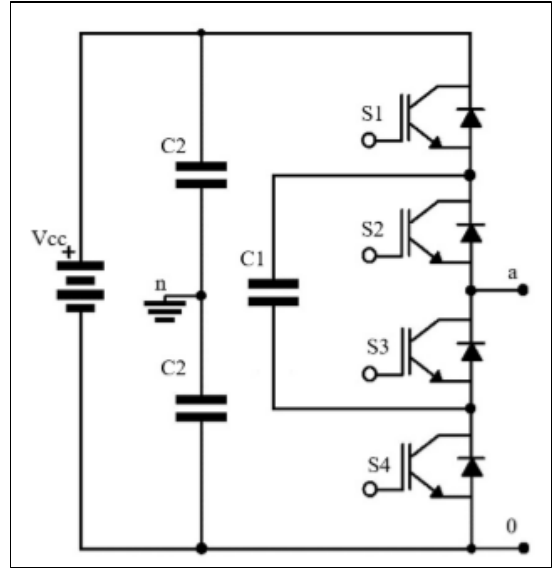
Figure 2: Inverter Topology with Three-Level Floating